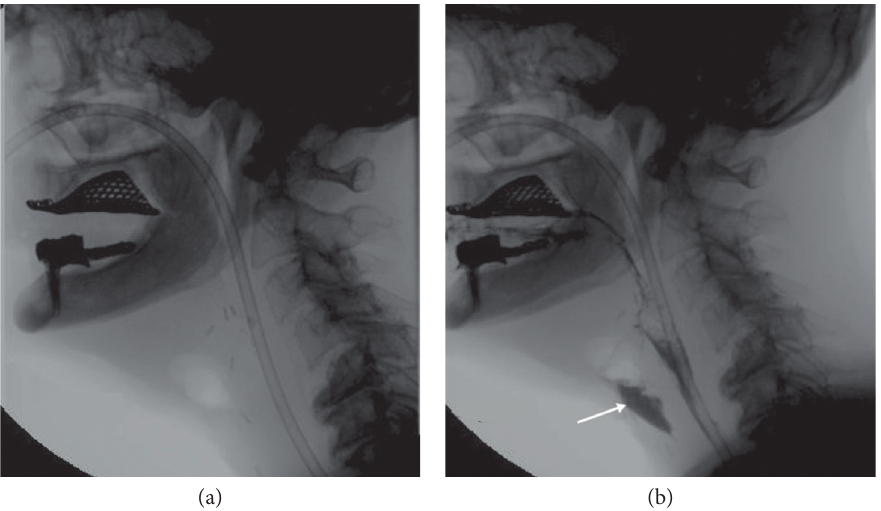
Figure 4: Lateral fl uoroscopic views of a 67-year-old man who has undergone a total laryngectomy with fi stula. A radiolucent area in front of the neopharynx suggests fi stula (a). In (b), an extraluminal collection of liquid barium (white arrow) con fi rms the presence of fi